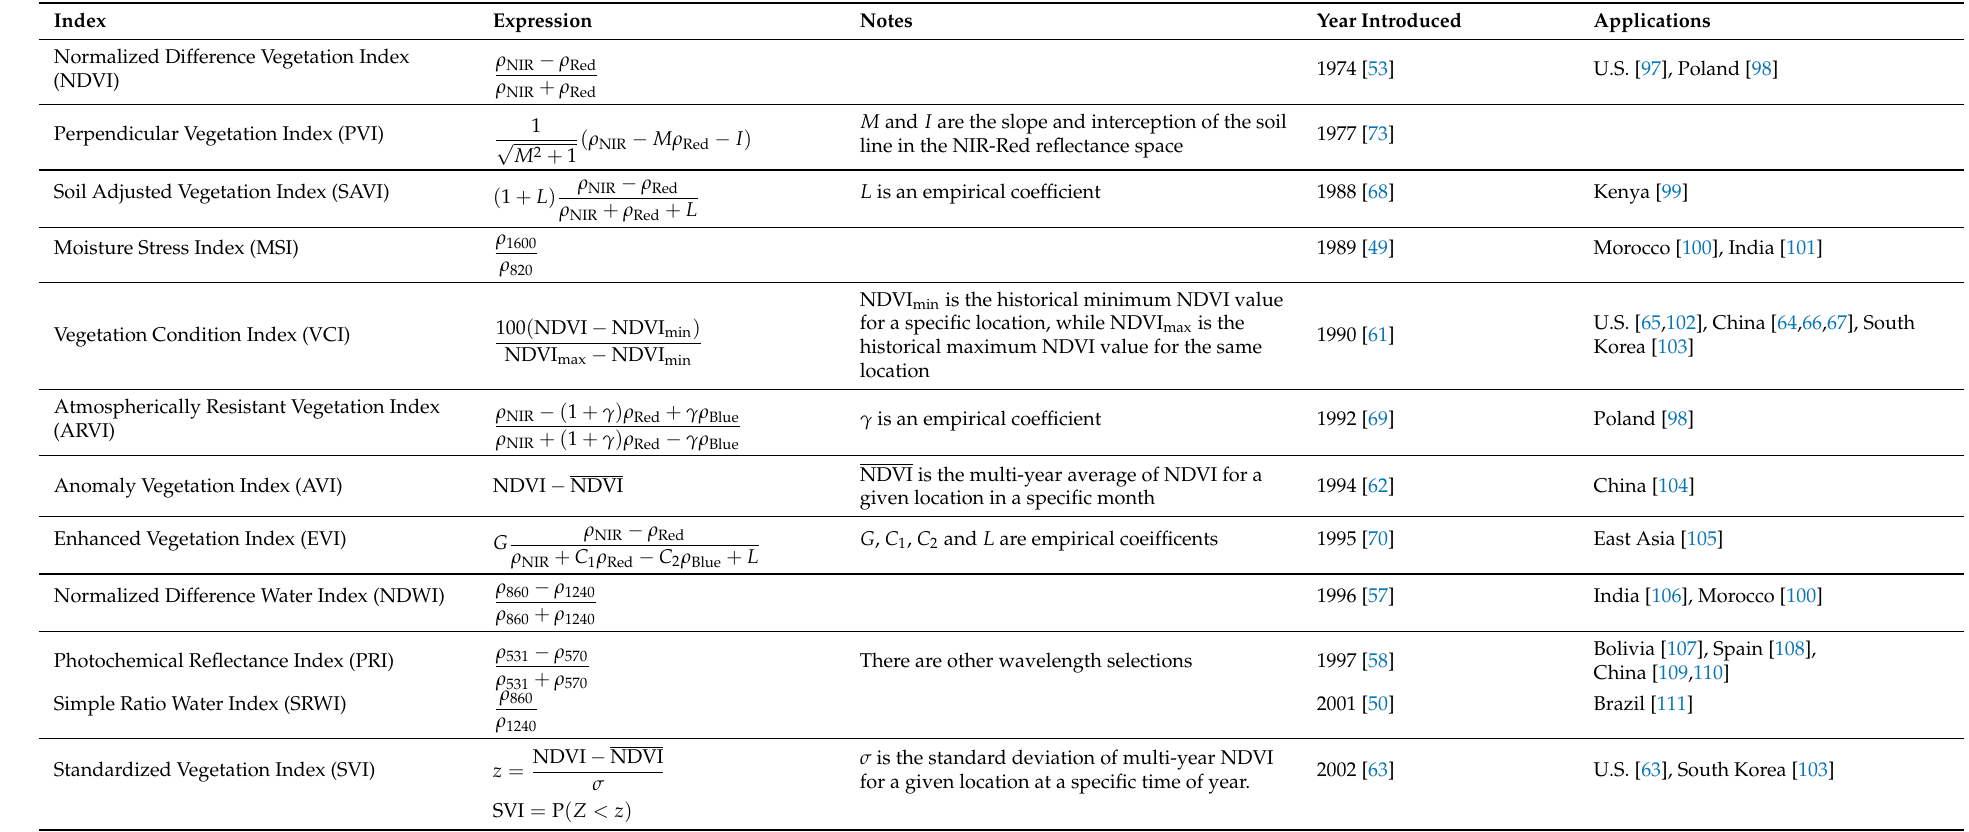
Table 1. Summary of spectral indices suitable for agricultural drought